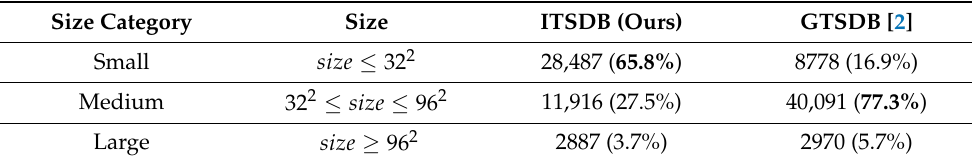
Table 1. The quantity of icons of different sizes in the